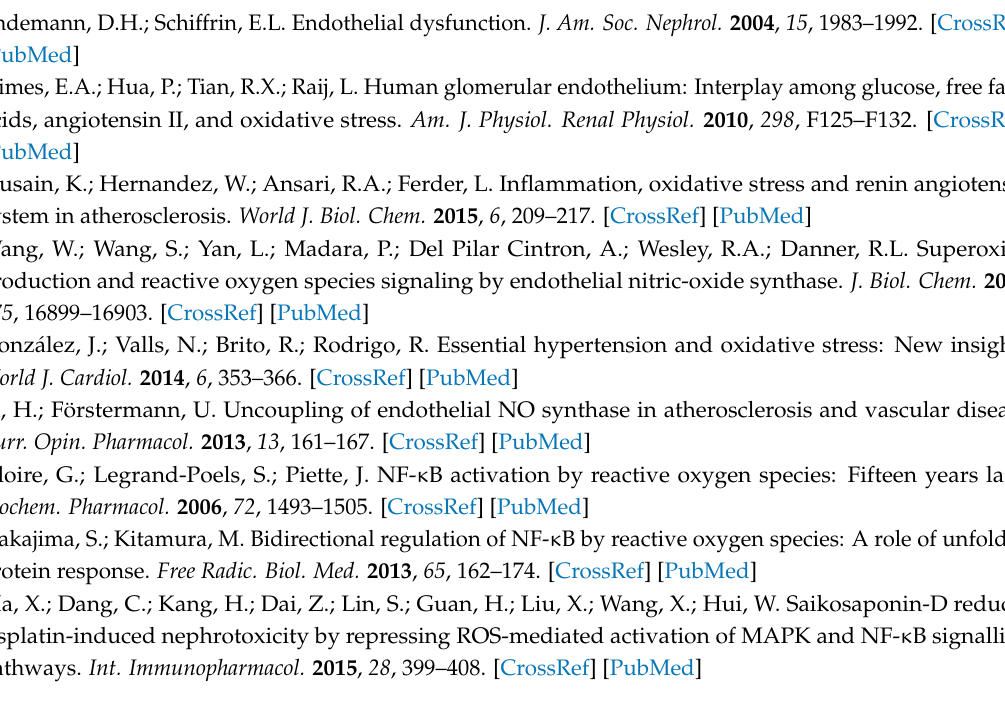
Supplementary Figure S1. Effect of C4 on Ang II-induced ICAM-1 expression, 12 h after treatment. Supplementary Figure S2. Thin-layer chromatography. Supplementary Figure S3. Mass